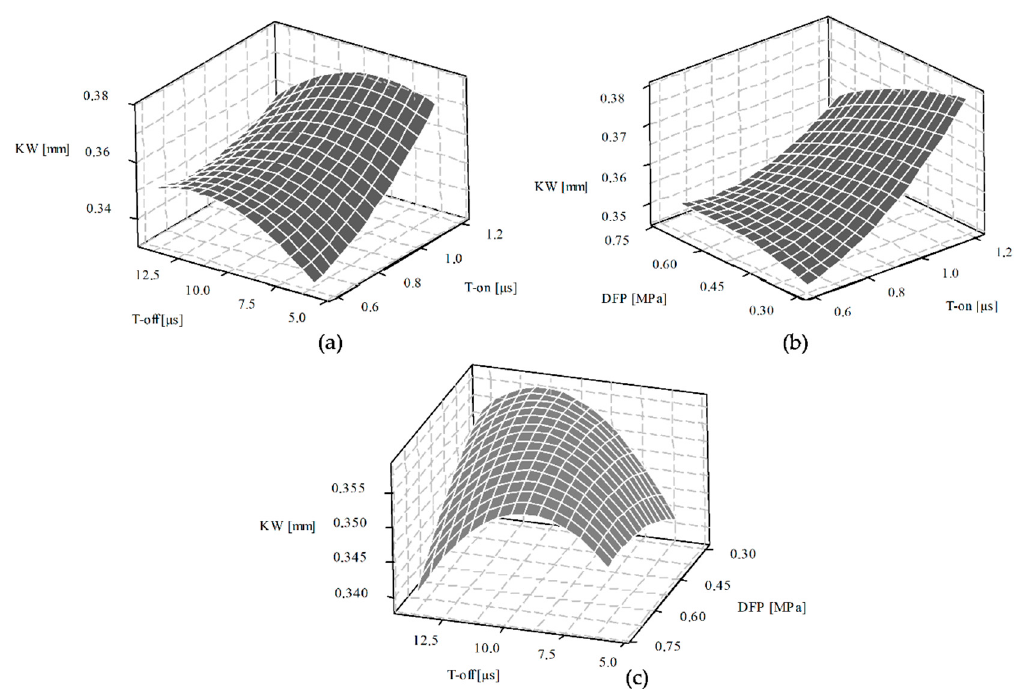
Figure 6. Response surface 3D plots representing the KW dependence on: ( a ) T-on and T-off, for DFP = 0.5 MPa; ( b ) T-on and DFP, for T-off = 10 µs; ( c ) T-off and DFP, for T-on = 0.9 µs.